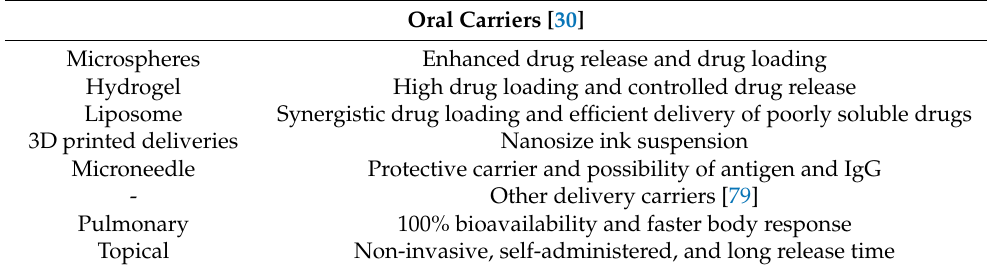
Table 2. Comparison of oral carriers and other delivery methods.